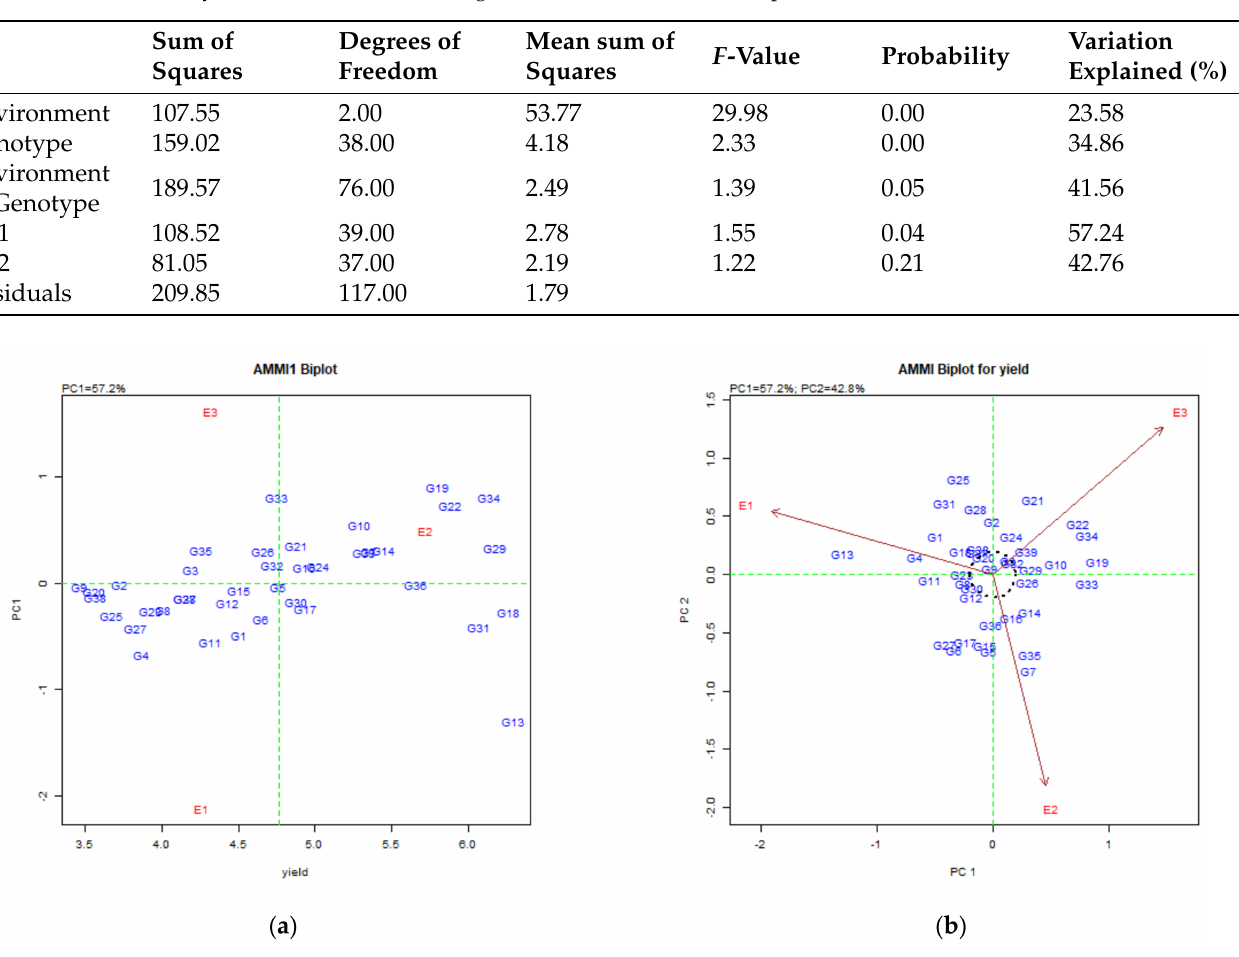
Figure 5. AMMI model: ( a ) AMMI-I explaining main and IPCA-1 interaction for grain yield; ( b ) AMMI-II explaining interaction effect of IPCA-1 and IPCA-2 for grain